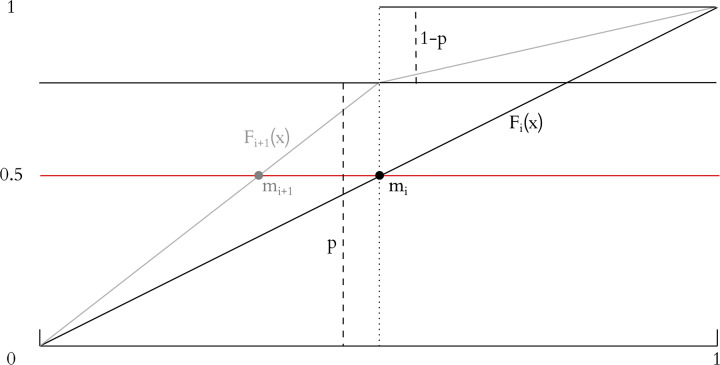
The key step of the Horstein algorithm: Distorting the CDF.The CDF transition is shown for the case where the initial transition is b0 = 0. The CDF Fi(x) is initially a line segment with gradient 1. It is partitioned at the point mi where Fi(x) = 0.5 and the left and right gradients are scaled by factors p and 1 − p. In the case b1 = 1, the respective factors would be 1 − q and q.